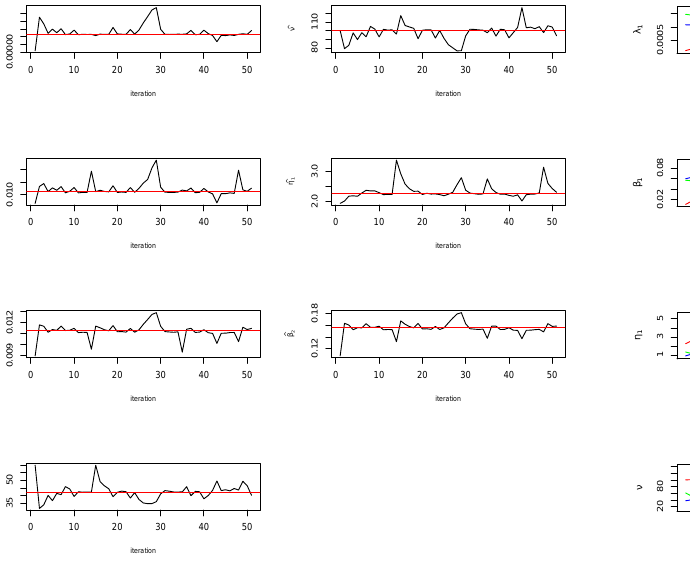
Fig. 2. Parameter estimates plotted against iteration (January; cen- tral region), illustrating Step (e) in the fitting procedure with n =50 iterations. The median (red line) is the overall parameter estimate.